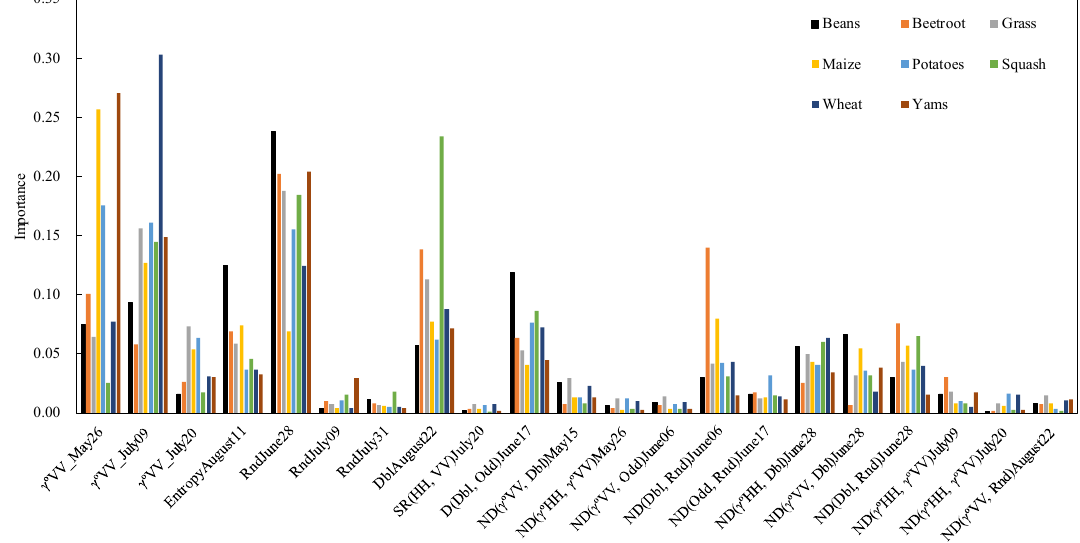
Figure 4. The data-based sensitivity analysis (DSA) results for each crop type.